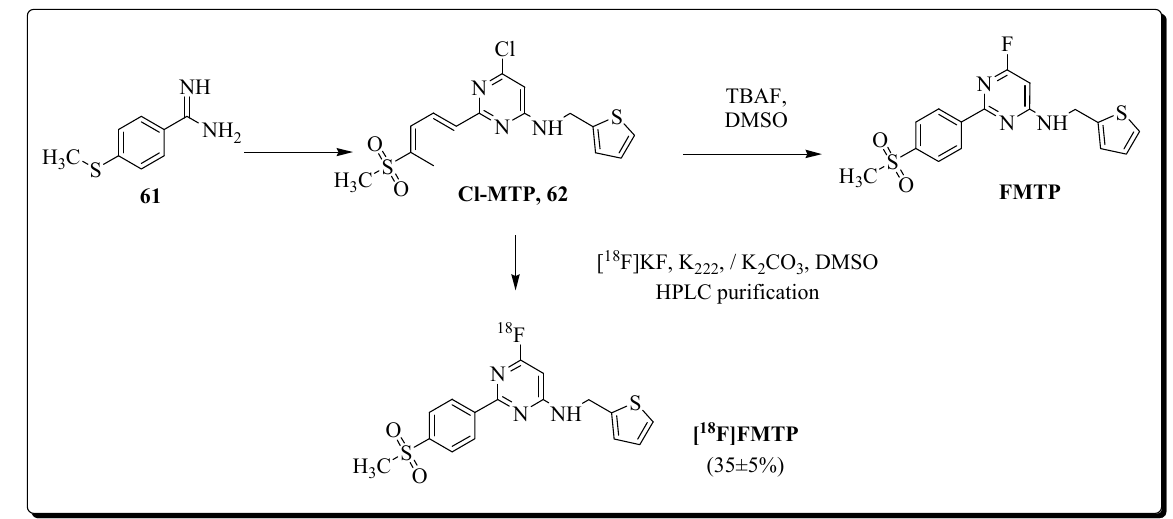
Figure 19. Synthesis of FMTP and radiosynthesis of [ 18 F]FMTP.